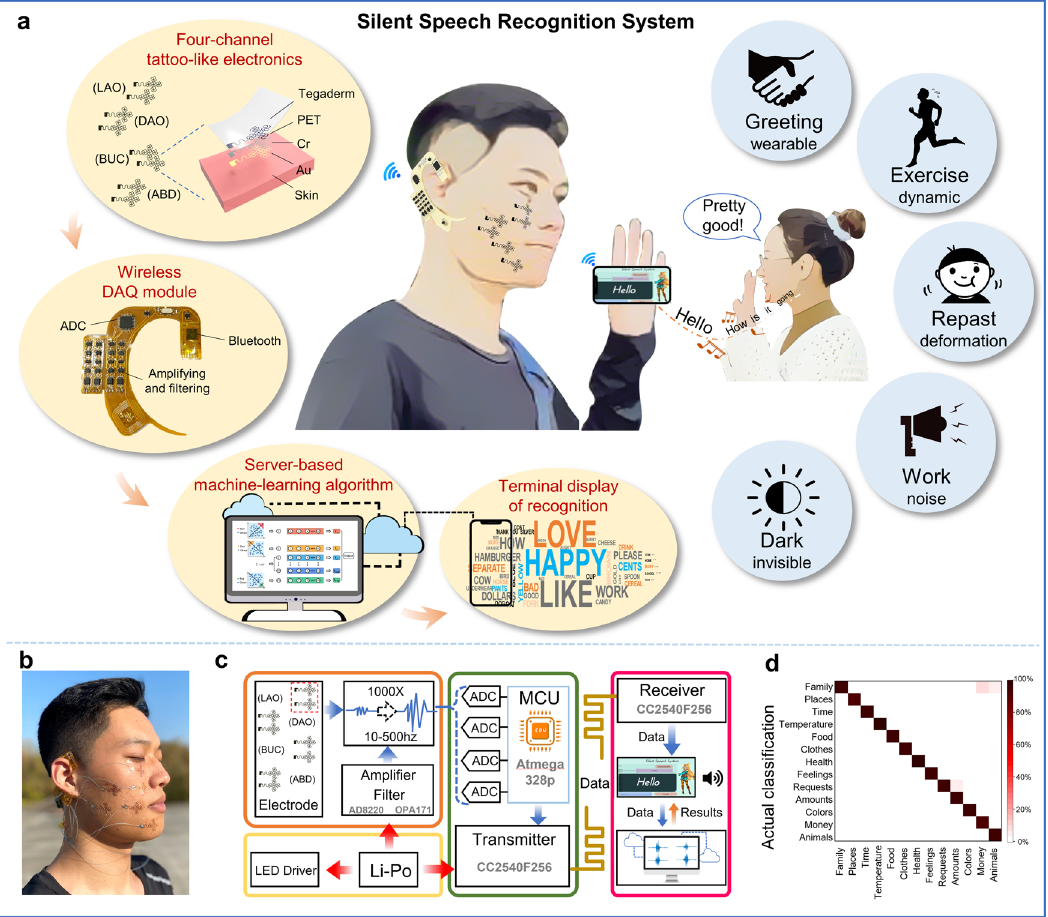
Fig. 1 Design of silent speech recognition system. a Schematic illustration of an all-weather, natural SSRS, including four-channel tattoo-like electronics, the wireless DAQ module, the server-based machine-learning algorithm, and the terminal display of recognition, with adaptability in various scenarios. The identi fi able drawing is fully consented by the written consent. b The photograph of a participant wearing the SSRS. The identi fi able photograph is fully consented by the written consent. c Functional block diagram of the wireless DAQ module. d Confusion matrix of recognition results of the frequently used 110 words. The words are from 13